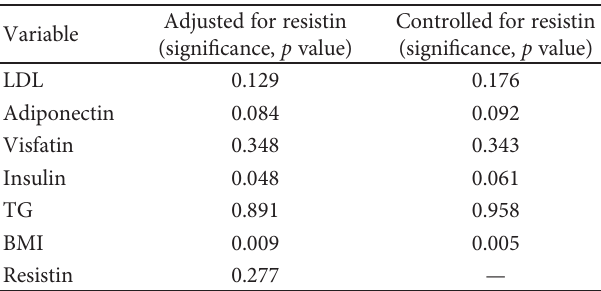
Table 3: Serum leptin levels in nondiabetic males (multiple regression model when controlled for